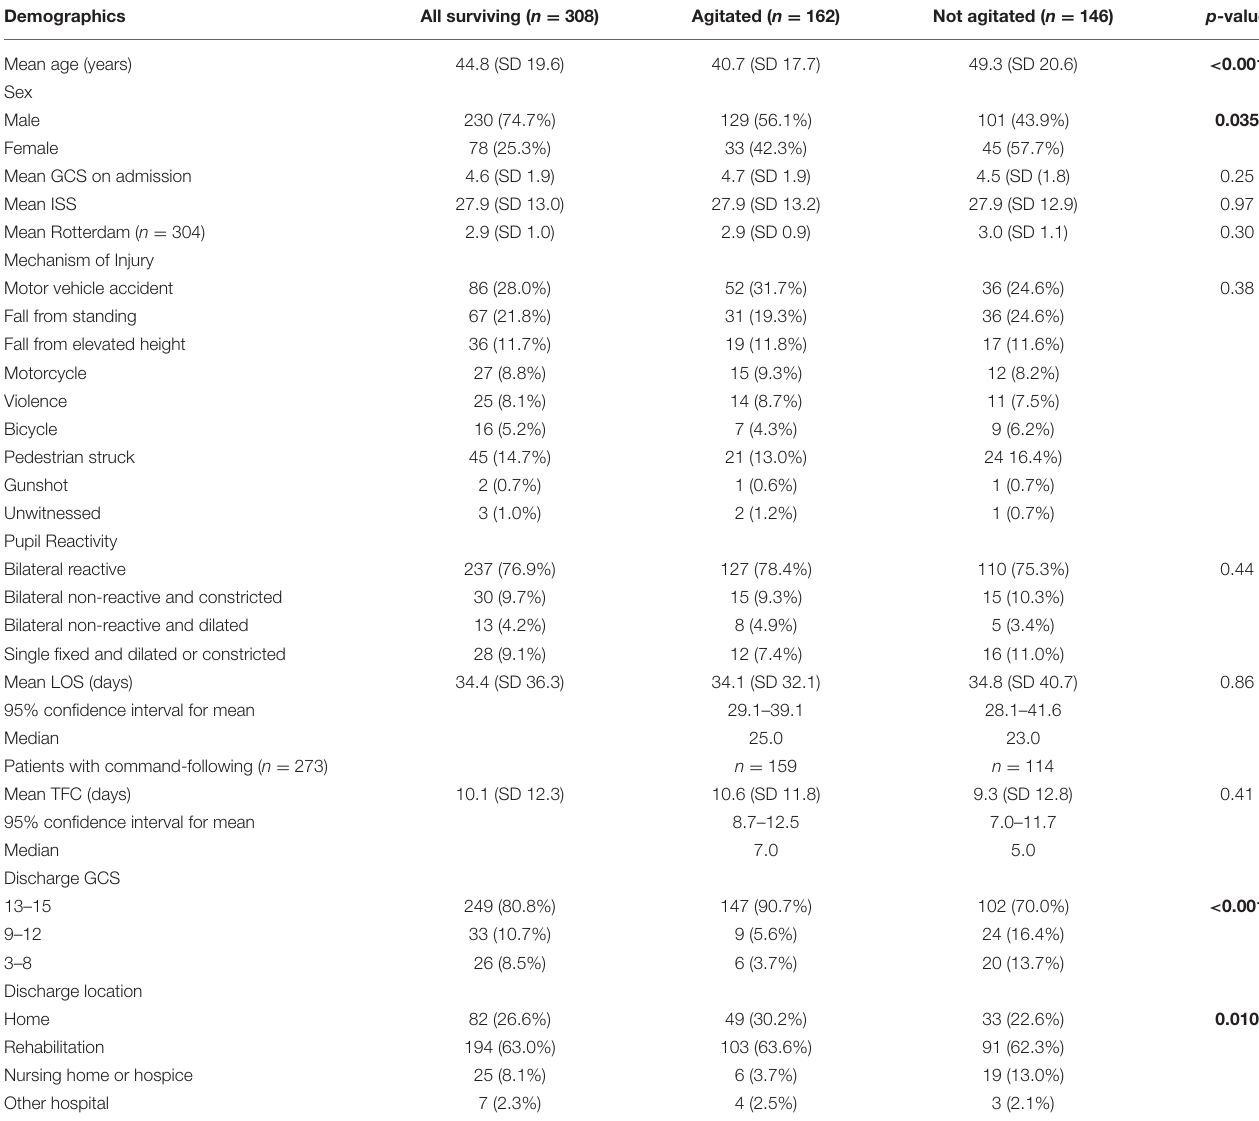
TABLE 2 | Patient characteristics and clinical outcomes of surviving agitated and non-agitated patients, n = 308.